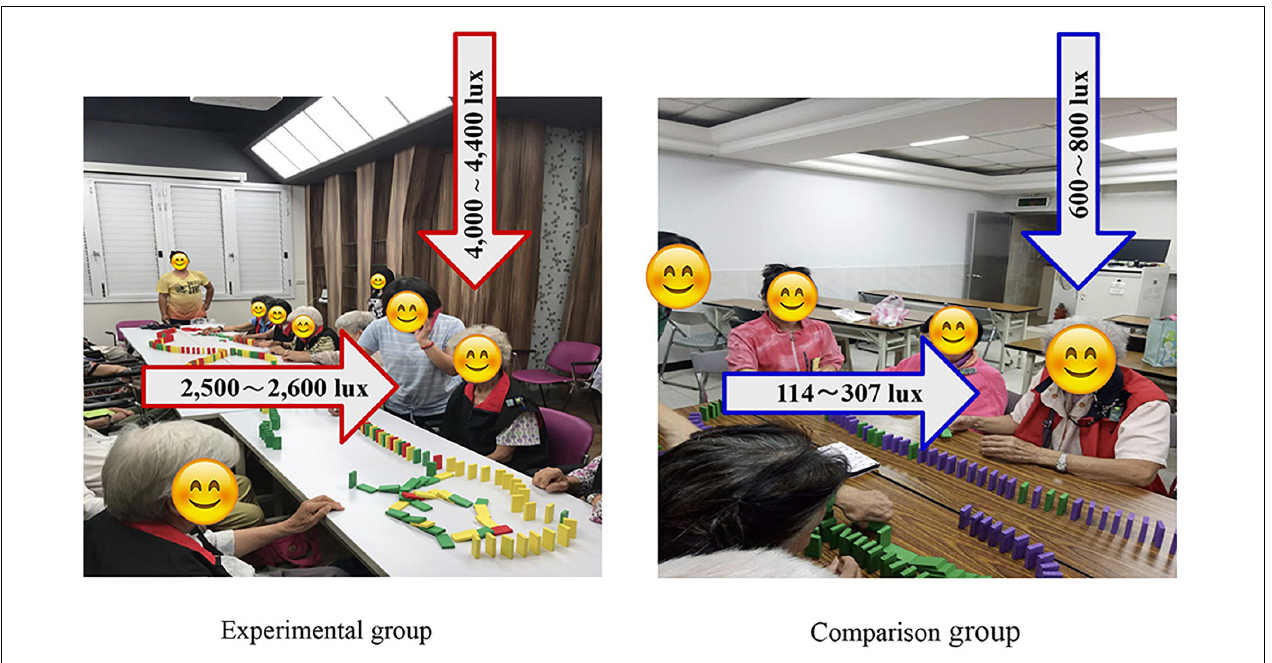
FIGURE 2 | Design of ambient conditions for exposure to bright light therapy and general